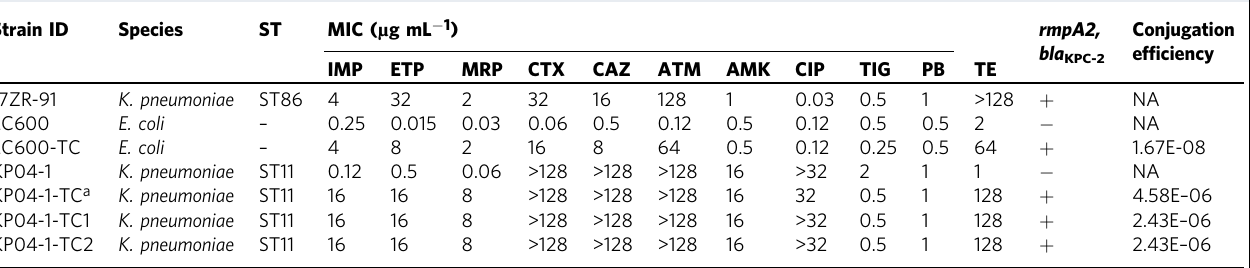
Table 1 Characteristics of carbapenem-resistant K. pneumoniae 17ZR-91 and corresponding transconjugants. Strain ID